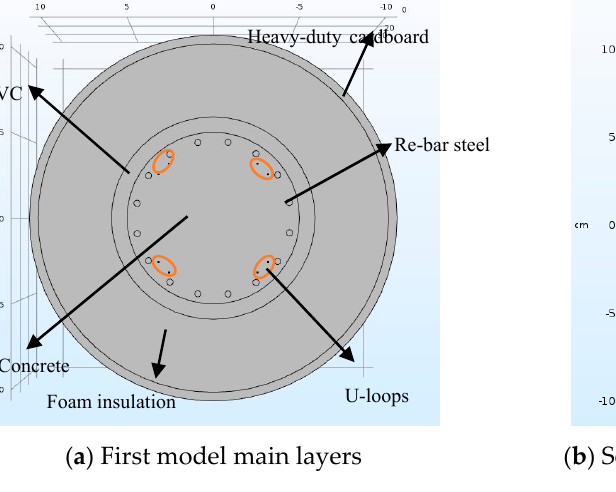
Figure 6. 3-D geometry and meshing. Table 4. Layer thermal